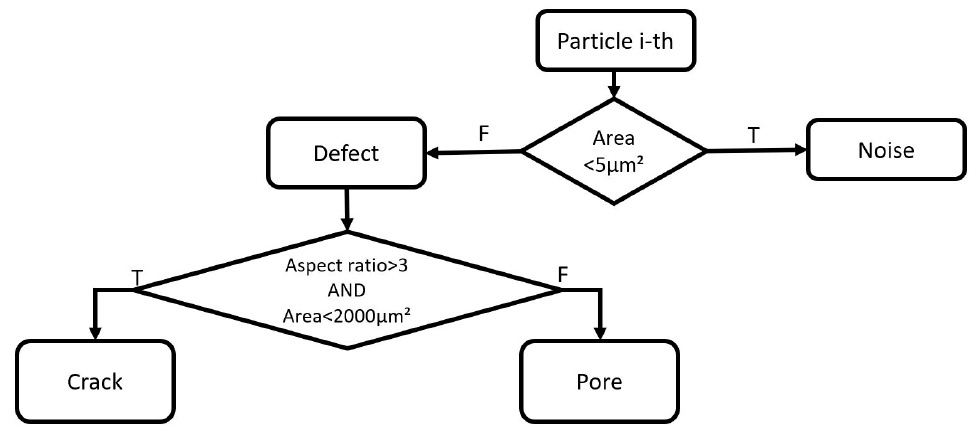
Figure 3. Particle classification flowchart.